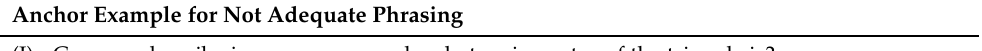
Table 8. Not adequate paraphrasing of Participant E and P1-1 (cf. Table A1 in the Appendix A). Anchor Example for Not Adequate